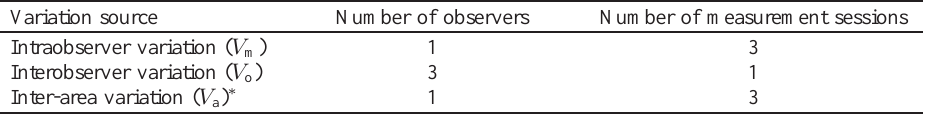
Table 2 Analysis of sources of variation in measuring nuclear profiles areas. A total of 20 samples